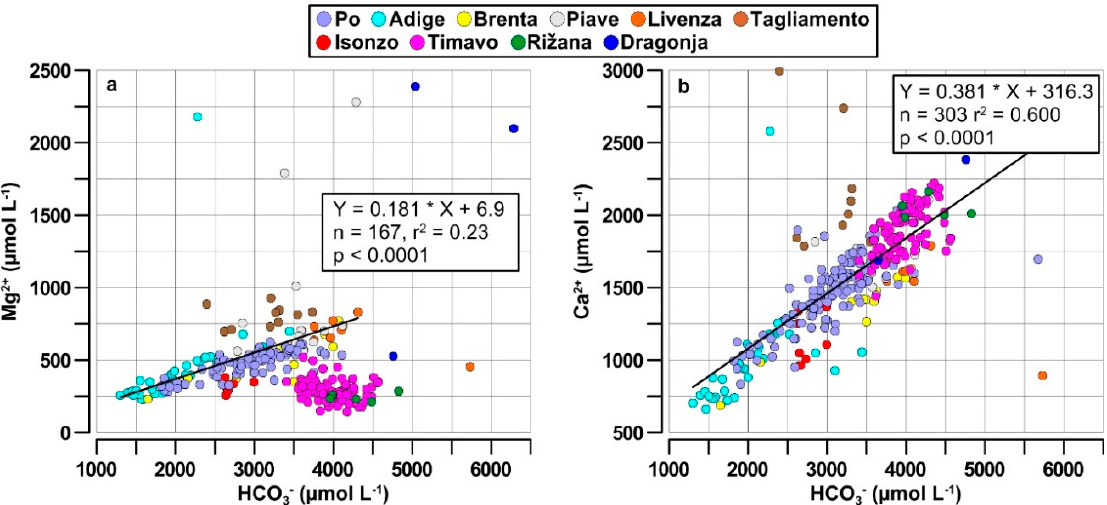
Figure 3. Relationships of the concentrations of ( a ) Mg 2+ and ( b ) Ca 2+ versus HCO 3 − ( μ mol L − 1 ). Linear regressions were calculated for ( a ) the rivers from the Po to Isonzo and ( b ) for all the NAd rivers. The Timavo, Rižana and Dragonja rivers had low Mg 2+ concentrations that were